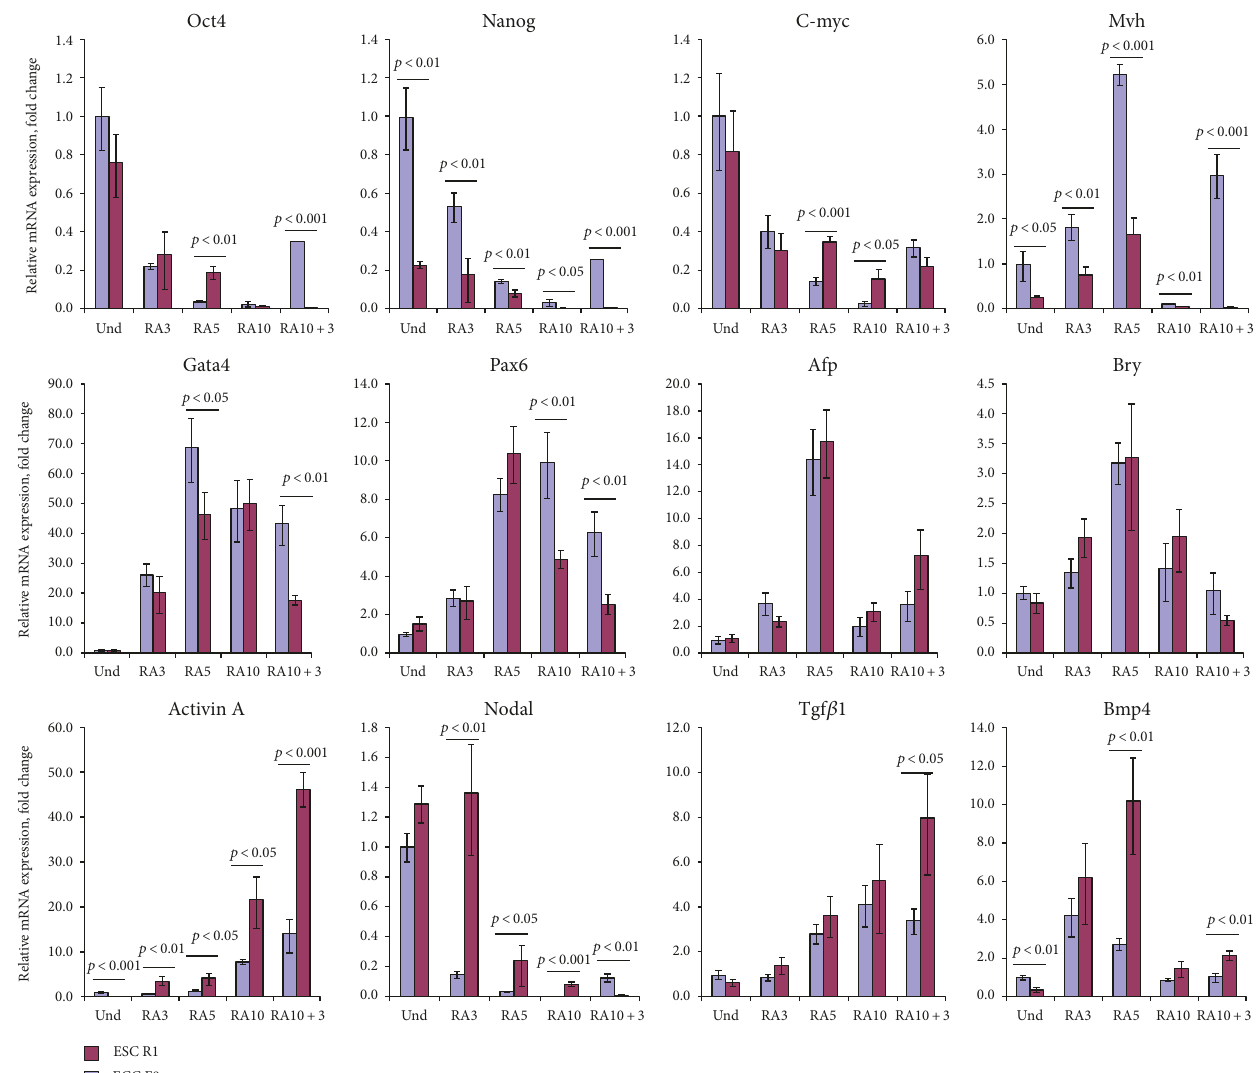
Figure 2: The gene expression patterns of pluripotency and embryonic lineage markers and TGF β factors in the course of RA-induced di ff erentiation of ES R1 and EC F9 cells. The gene expression levels of each gene in di ff erentiated cells were evaluated relative to the gene expression levels in undi ff erentiated ES R1 cells. The data are represented as the mean ± s.d.; signi fi cant di ff erences were estimated using